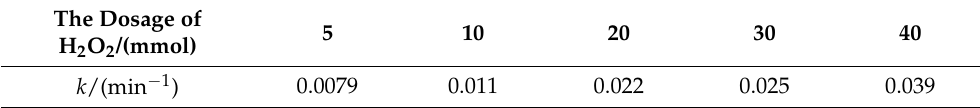
Table 3. Kinetic rate constants with different dosages of H 2 O 2.